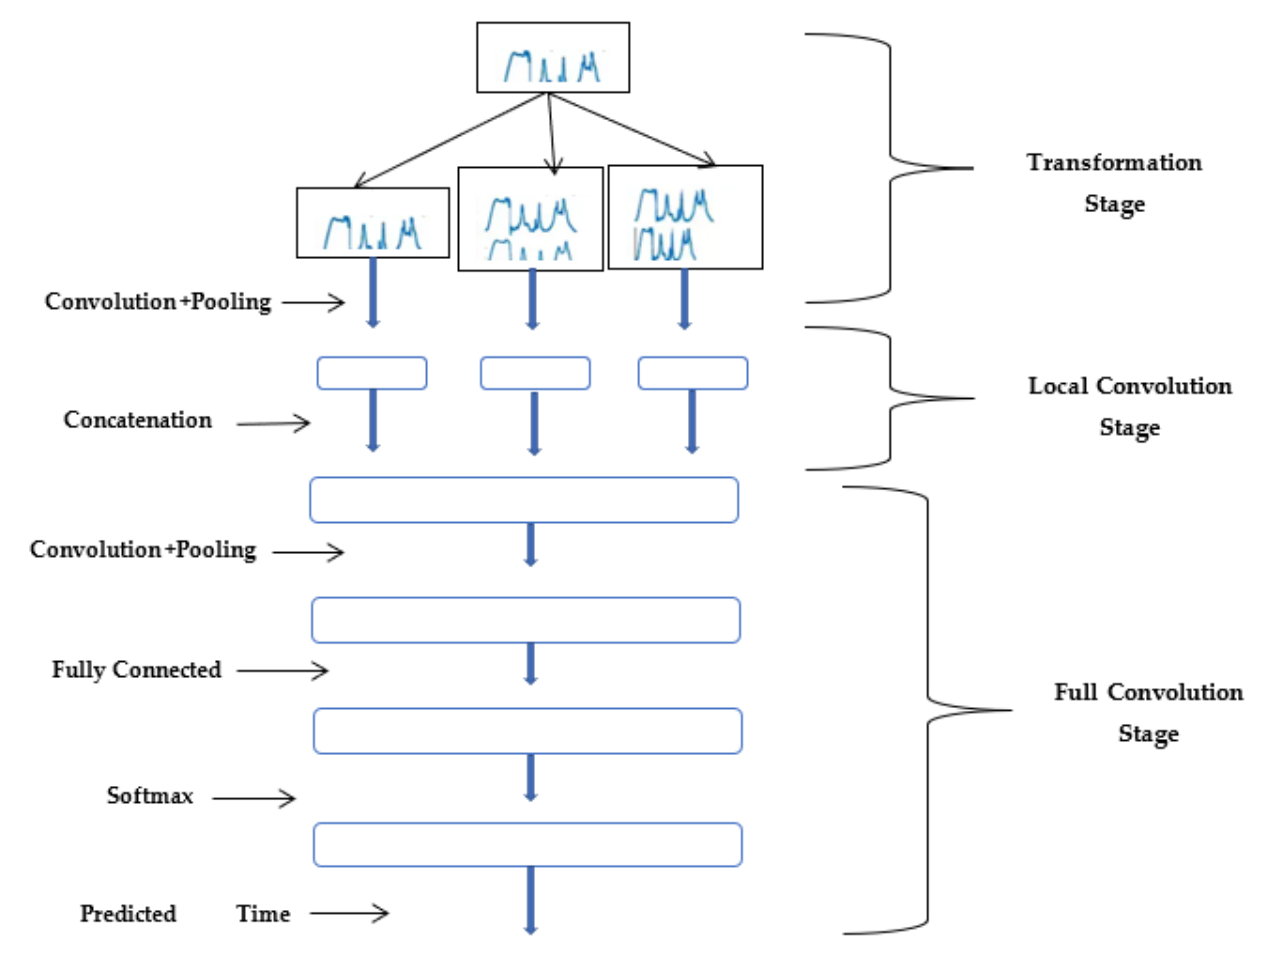
Figure 2. Conceptual model of